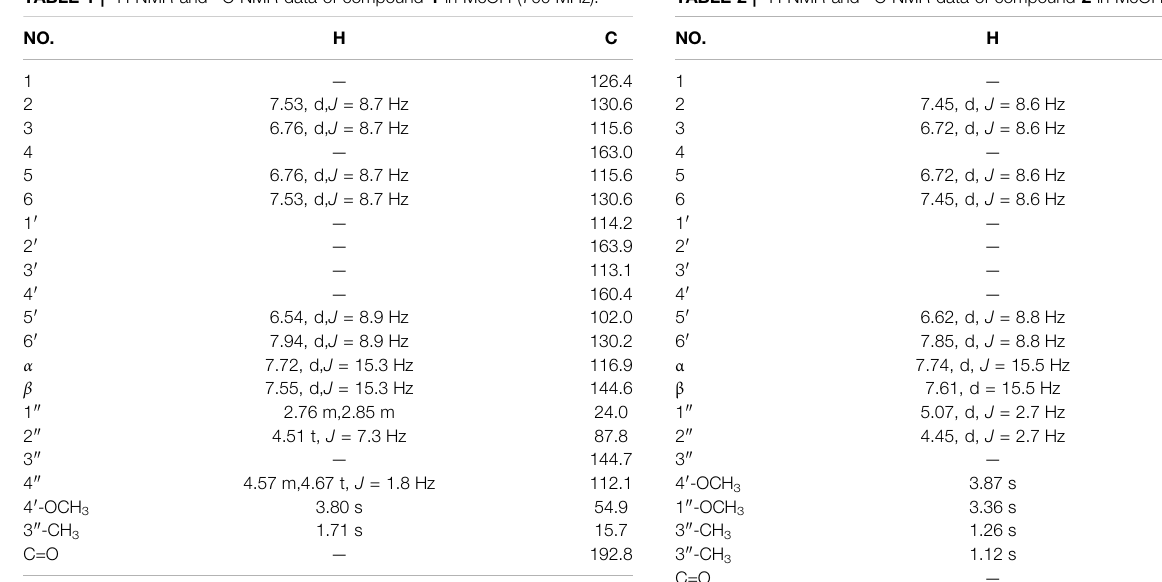
TABLE 2 | 1 H NMR and 13 C NMR data of compound 2 in MeOH (700